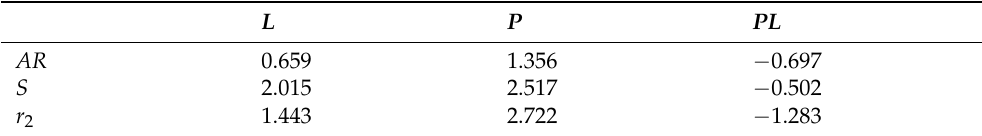
Table 8. Comparison of the exponent a of different sensitivity parameters at 28